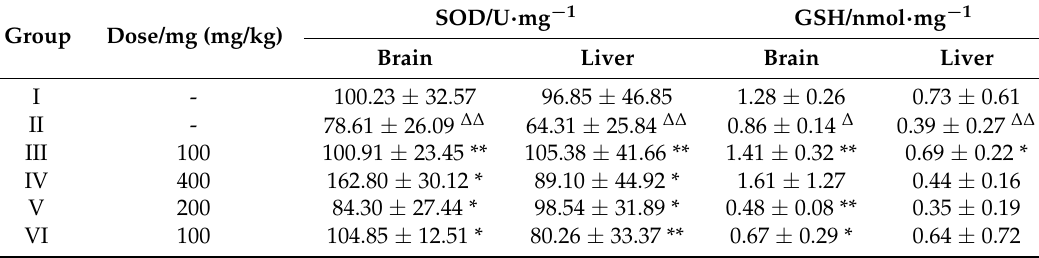
Effects of Paeonia rockii flower extracts on brain and liver SOD and GSH in D -galactose-induced